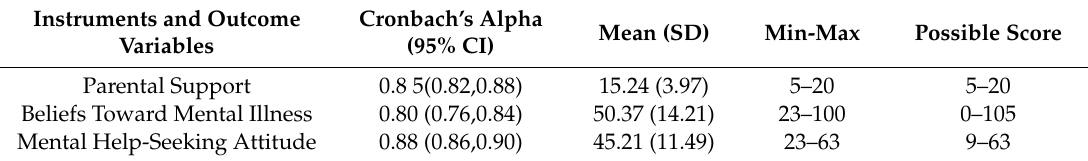
Table 2. Reliability (internal consistency) of three instruments and descriptive statistics of outcome variables: Parental Support, Beliefs Toward Mental Illness, and Mental Help-Seeking Attitude ( n =